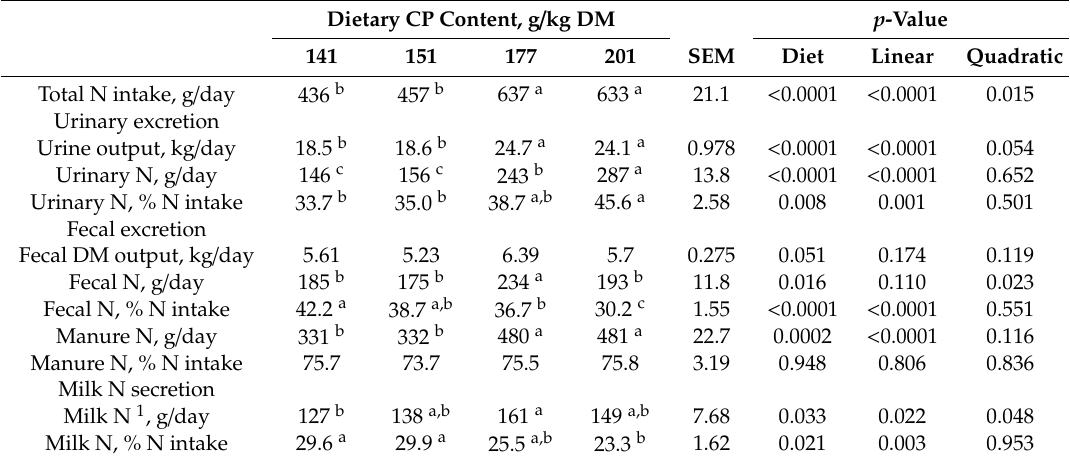
Table 5. E ff ect of dietary CP level on milk N secretion, and N excretion in feces and urine. Dietary CP Content, g / kg